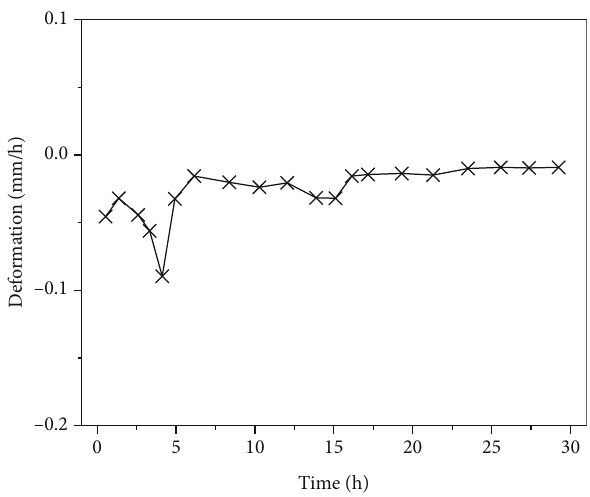
Figure 13: Deformation rate vs. time for soil HC.